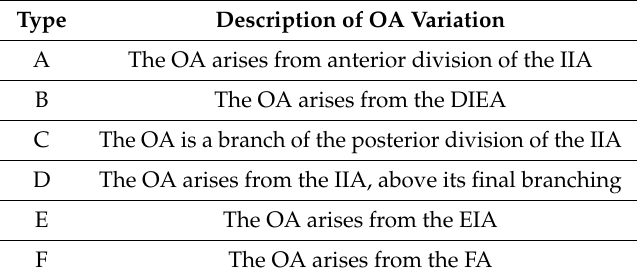
Table 2. Sañudo et al. (2011) [8] obturator artery variation types. OA = obturator artery; DIEA =